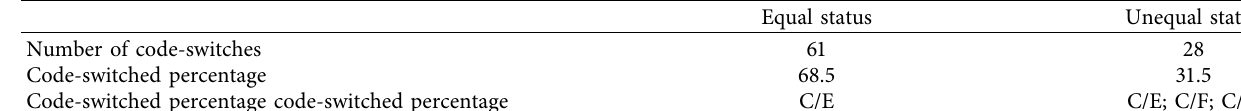
Table 4: Distribution of code-switching in different tenses.